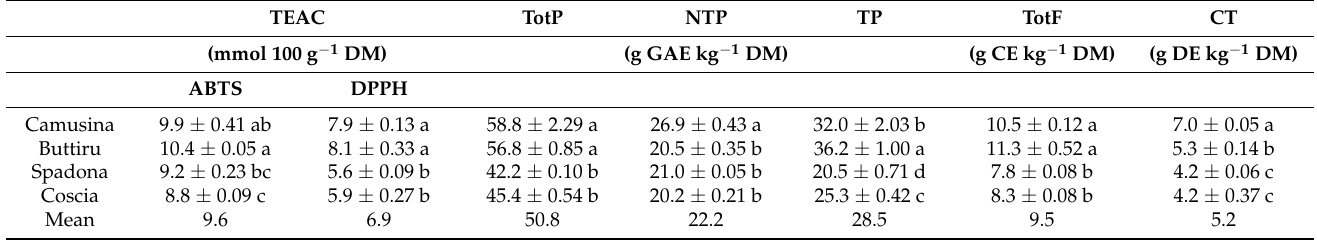
Table 4. Total antioxidant capacity (TEAC) by ABTS and DPPH methods, total phenolics